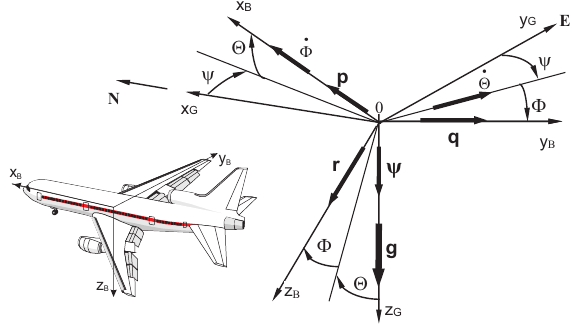
Figure 2. Body-fixed (0x B y B z B ) and Earth-fixed coordinate system (0x G y G z G ): p , q , r – angular rates in the body- fixed coordinate system, Θ – pitch angle, Φ – bank